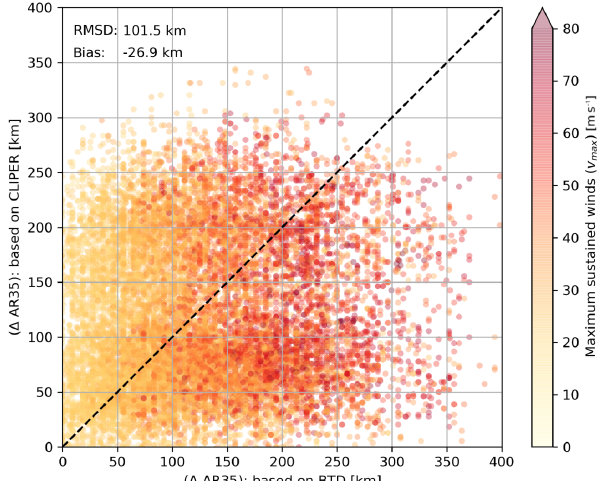
Figure 5. Scatter plot describing BTD (cid:49) AR35 ( x axis) versus com- puted (cid:49) AR35 based on CLIPER ( y axis). Data points are colored- coded based on the maximum sustained wind speeds in the BTD. The dashed line represents a perfect fit between the BTD and the computed data based on